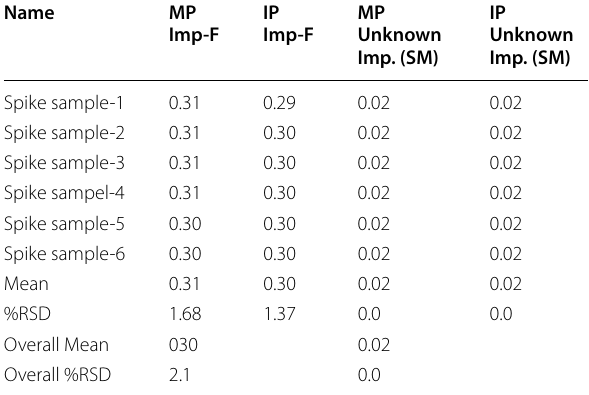
Table 8 Recovery for diltiazem EP impurity-F Levels Preparation